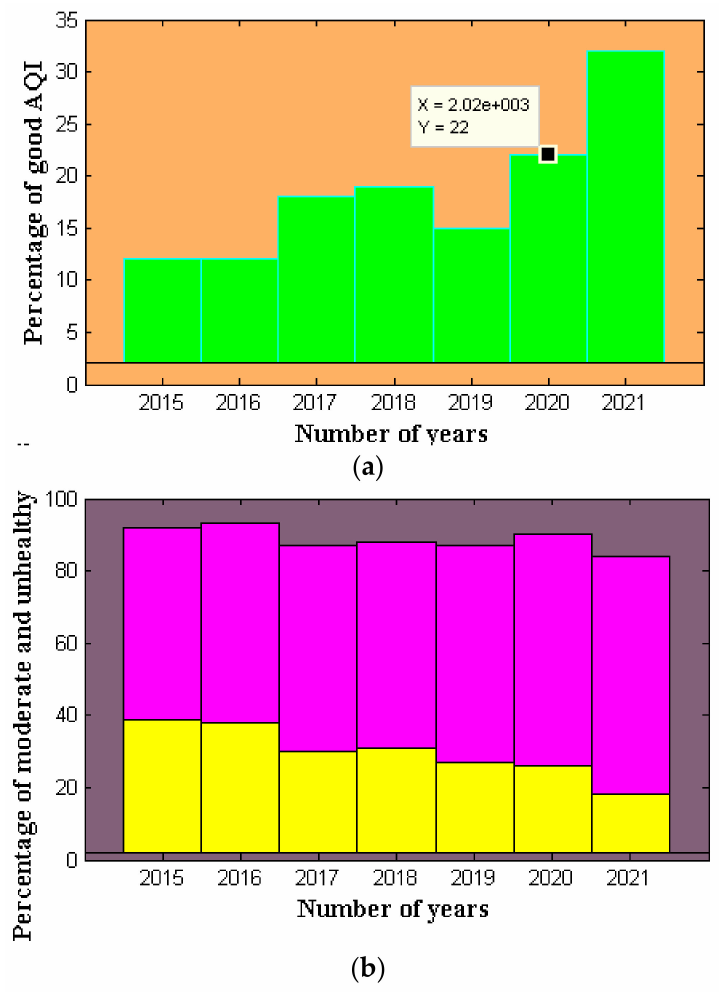
Figure 8. Year-based AQI ( a ) Good state. The green color indications proves that only good AQI values are achieved throughout the years. ( b ) Moderate and unhealthy state. The yellow and pink color indications proves that only moderate and unhealthy AQI values are achieved throughout the